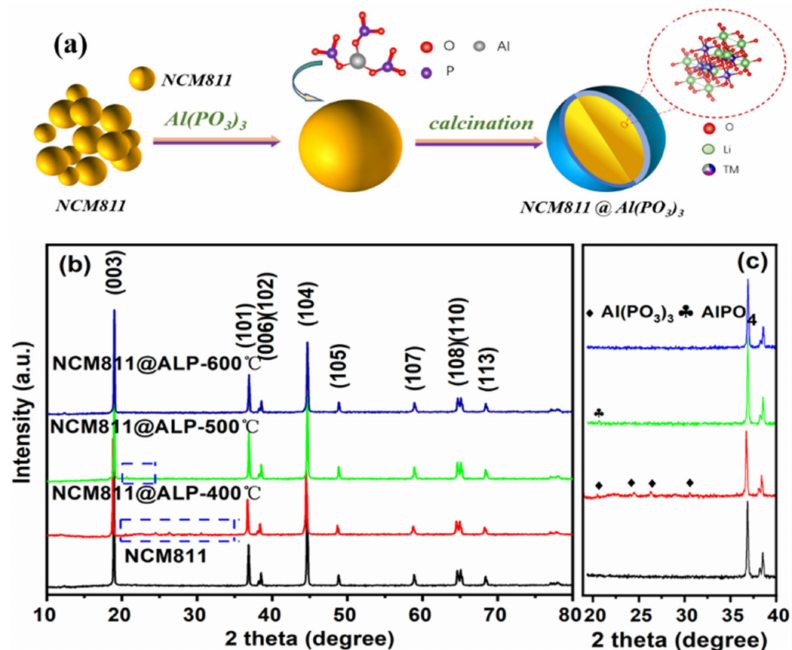
Figure 1. ( a ) The schematic diagram of the preparation process for NCM@Al(PO 3 ) 3 . ( b ) XRD patterns of pure NCM811 and Al(PO 3 ) 3 -modified NCM811 materials. ( c ) Zoomed-in XRD patterns of pure NCM811 and modified NCM811